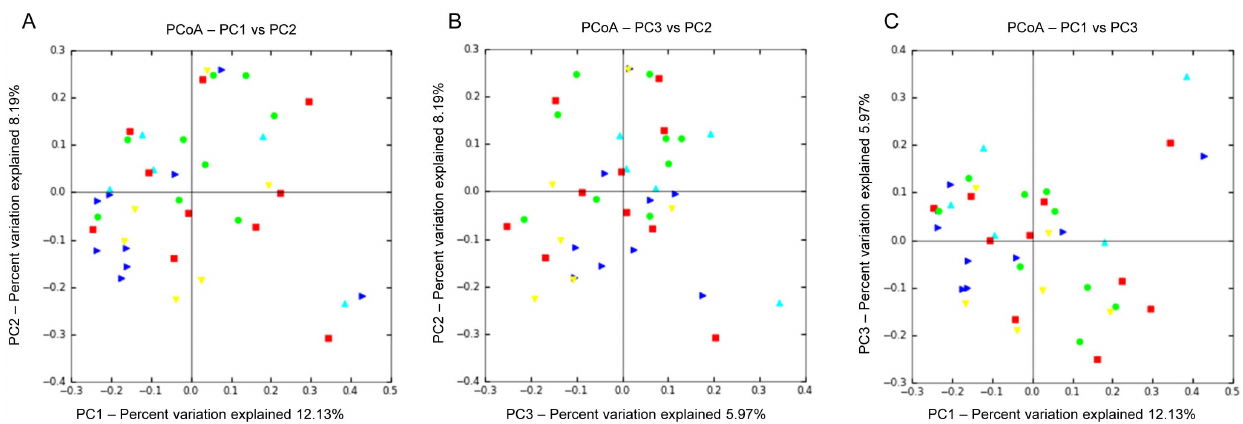
Figure 4. Principal coordinates analysis (PCoA) of unweighted UniFrac distances of 16 S rRNA genes. Analysis for 42 foals in groups control with CTB (red square), control without CTB (yellow triangle), low-dose inactivated R. equi (dark blue triangle), high-dose inactivated R. equi 2 (green dot), and live R. equi (light blue triangle) at 30 days of age only. Differences among groups were not significant (ANOSIM, P=0.449). The 3 panels represent the comparison of the first 2 principal components (A), the second and third principal components (B), and the first and third